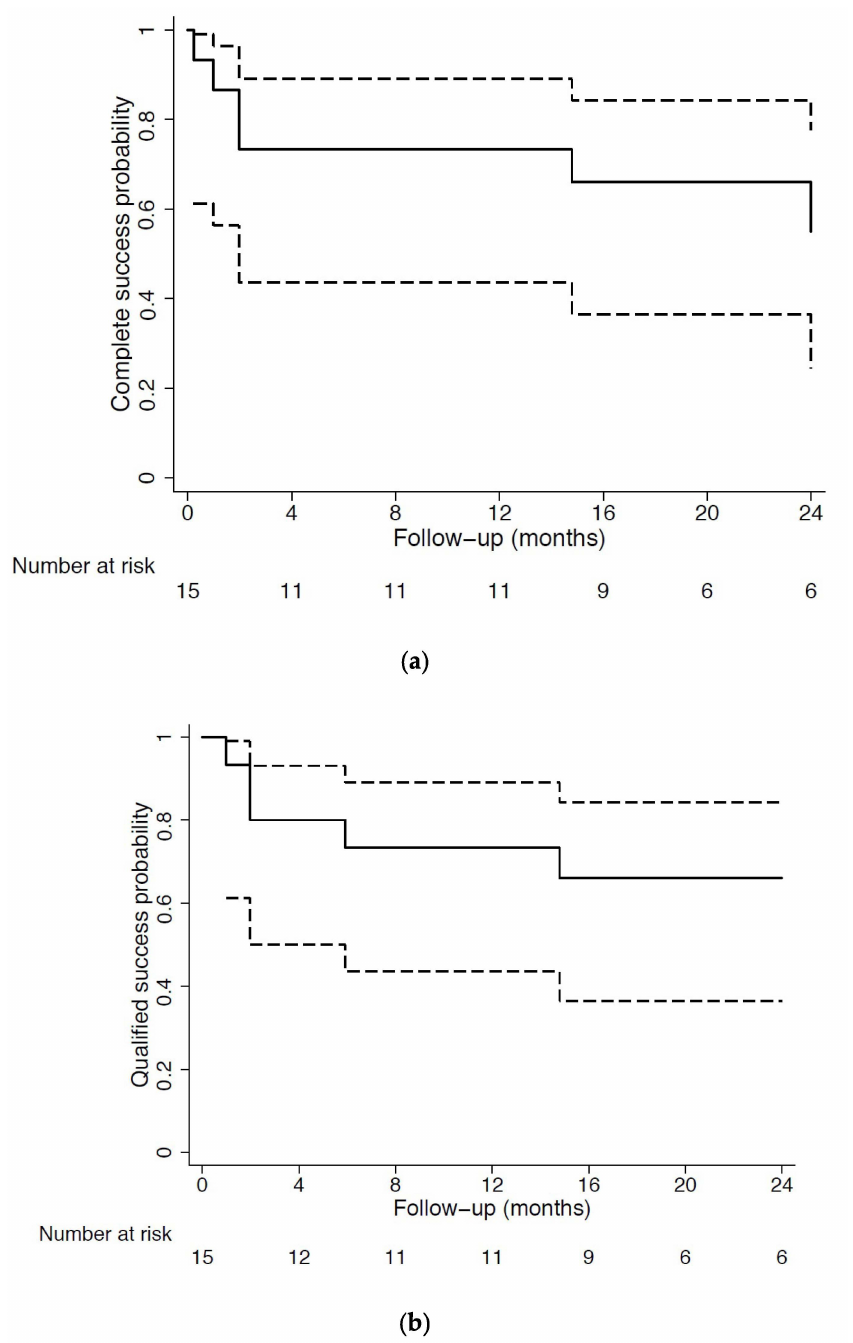
Figure 3. Cumulative probability of complete ( a ) and qualified ( b ) success (Kaplan–Meier curves) using the 15 mmHg or less intraocular pressure threshold. Table 2. Surgical success and failure rates against all